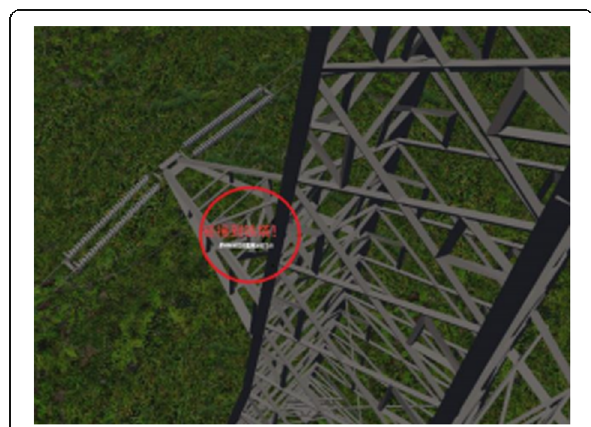
Fig. 11 Unmanned aerial vehicle collides with the tower